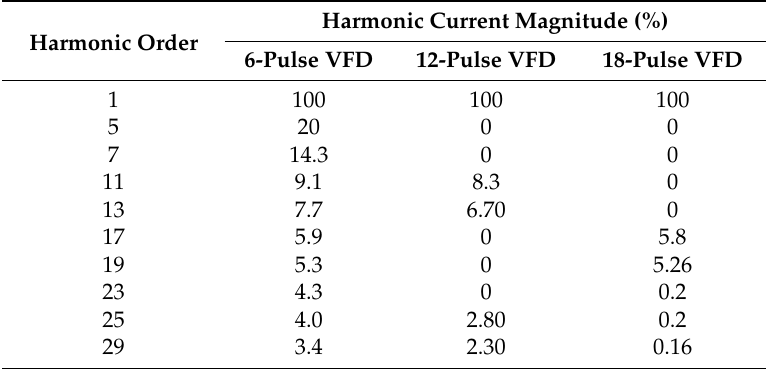
Table 5. Harmonic spectrum of the examined multi-pulse VFD systems.